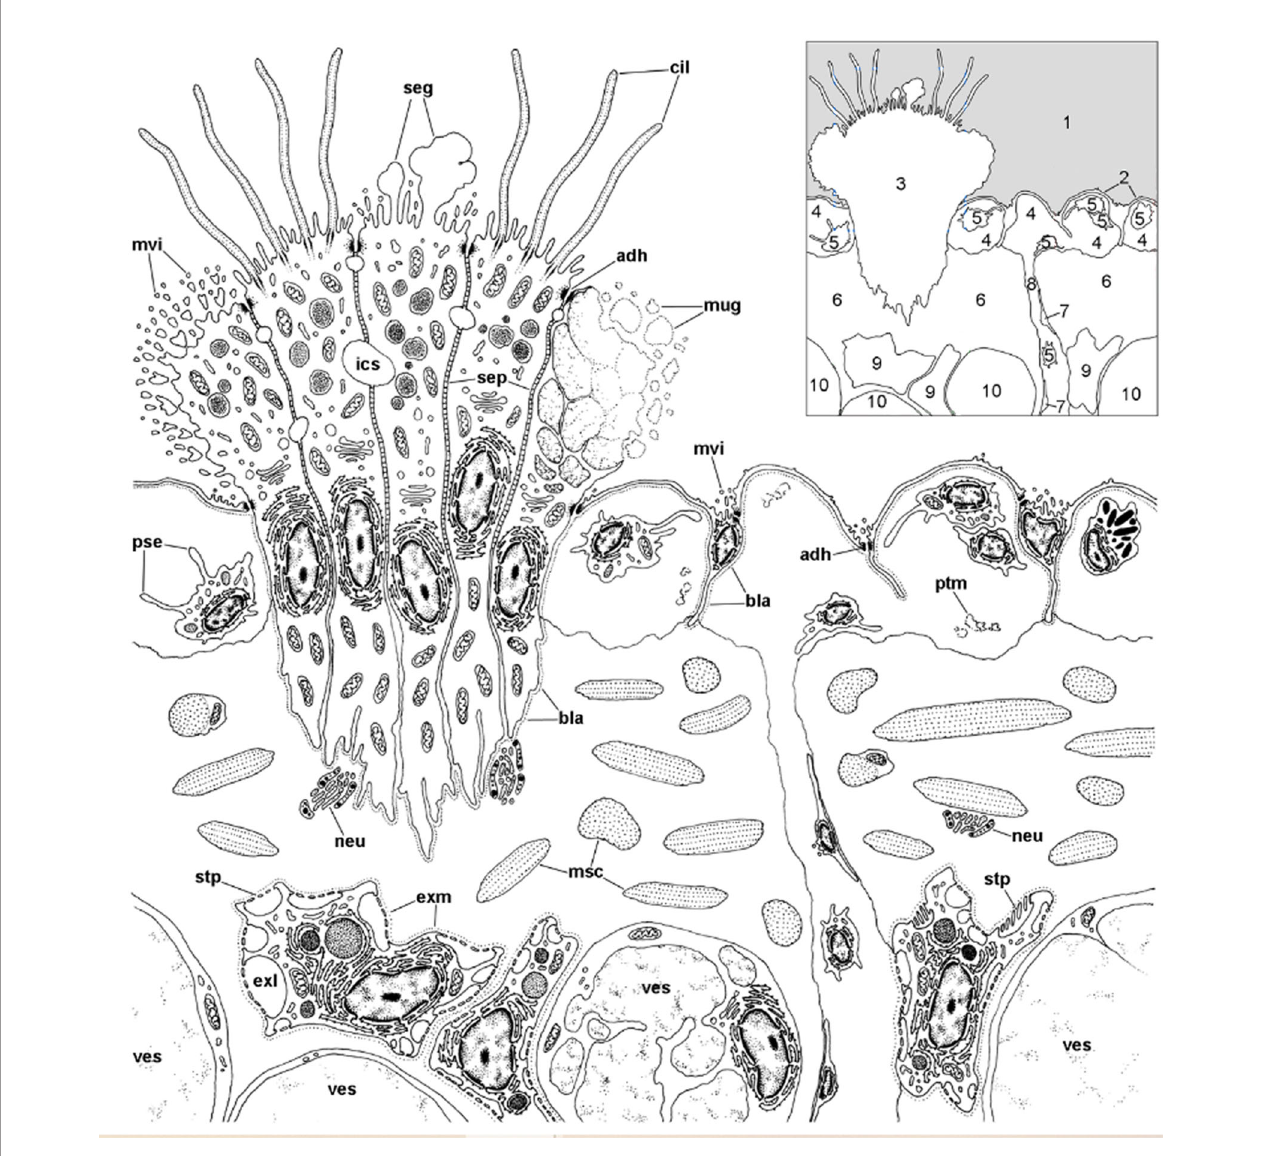
FIGURE 12 | Location of rhogocytes in the lung (illustration credit: Guido I. Prieto). The main structures are indicated in the thumbnail in the right-upper corner. The diagram depicts a portion of the respiratory lamina (with a ciliary tuft and some blood sinuses), the fi bromuscular layer that underlies it (the collagen matrix of the fi bromuscular tissue has not been drawn for clarity) and the upper part of the storage tissue layer. Rhogocytes mainly occur in contact with storage cells, but also with the perpendicular blood sinuses that feed the respiratory lamina and, less frequently, are found in the proximity of the basal part of the ciliary tufts (not shown in the diagram). Rhogocytes are encased in a thin lamina of extracellular matrix (dashed lines). 1, pulmonary cavity; 2, pavement cells; 3, ciliary tuft; 4, blood sinuses of the respiratory lamina; 5, hemocyte; 6, fi bromuscular tissue; 7, endothelial-like cell; 8, radial sinus; 9, rhogocyte; 10, storage cell; ADH, adherent junction; BLA, basal lamina; CIL, cilia; EXL, extracellular lacunae; EXM, extracellular matrix; ICS, intercellular space; MSC, muscle cells; MUG, mucin granules; MVI, microvilli; NEU, neurite bundle; PSE, pseudopodia; PTM, particulate material; SEG, secretory globules; SEP, septate junctions; STP, slit apparatus; VES, vesicles of storage cells. From